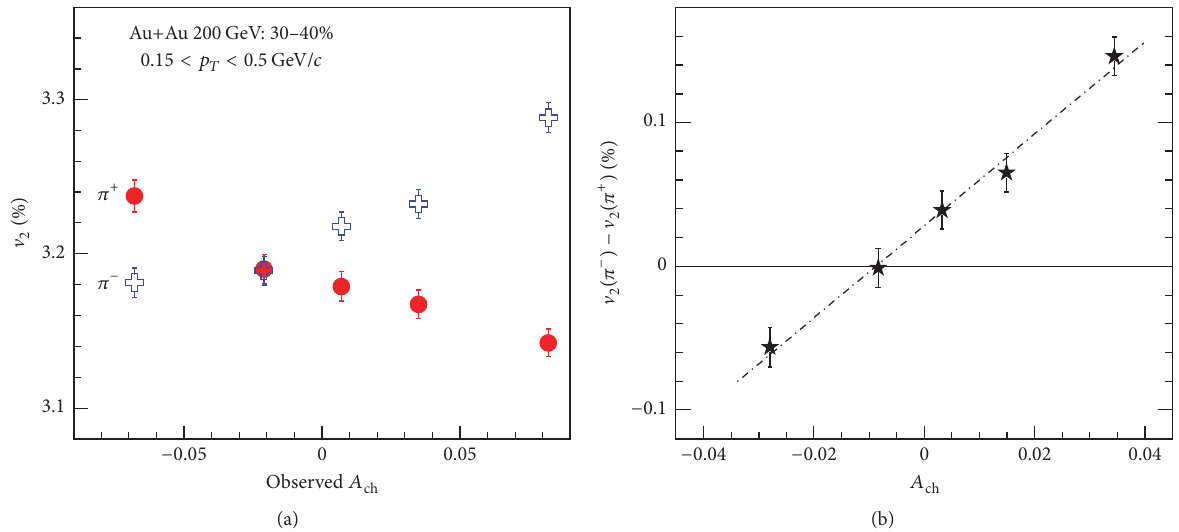
Figure 14: (a) Pion V 2 as a function of observed charge asymmetry and (b) V 2 difference between 𝜋 − and 𝜋 + as a function of charge asymmetry with the tracking efficiency correction, for 30–40% Au+Au collisions at 200 GeV